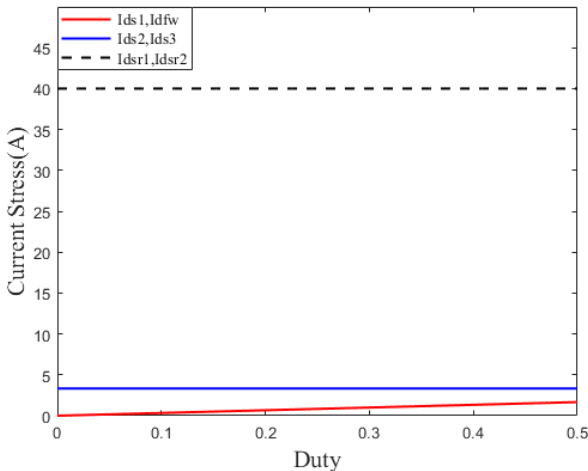
Figure 13. The estimated current stresses of switches and diode.